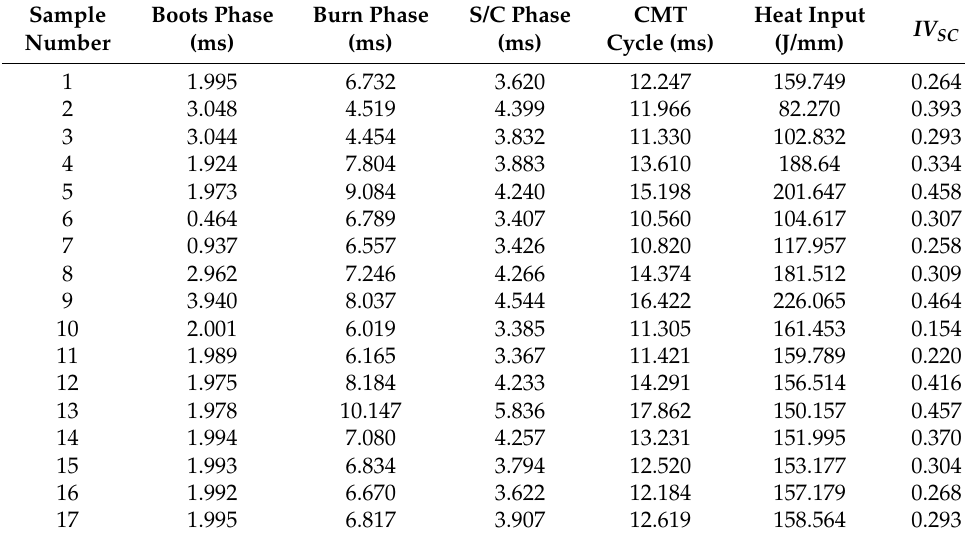
Table 3. Phase duration, heat input and IV SC with different CMT characteristic